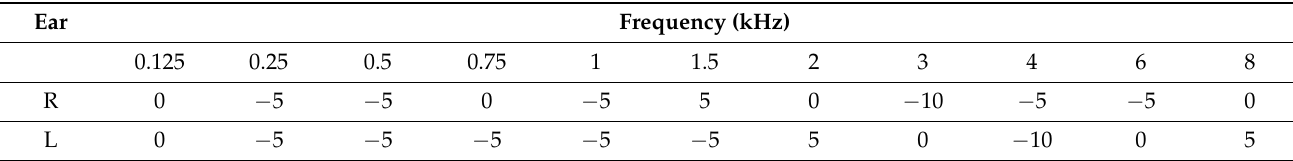
Table 1. Pure tone hearing thresholds for studied subject. R, right; L,